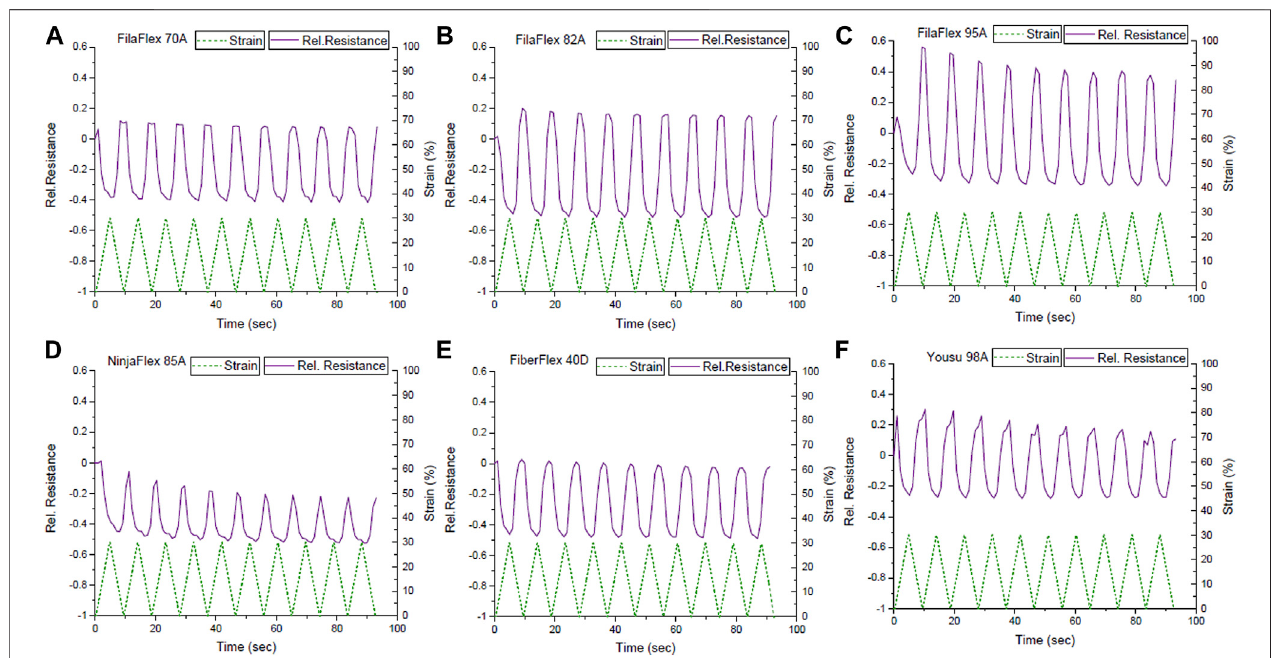
FIGURE 4 | Sensor response during dynamic tensile testing between 0 and 30% strains for the different TPU strips with in situ integrated strain sensing elements; (A) FilaFlex 70A, (B) FilaFlex 82A, (C) FilaFlex 95A, (D) NinjaFlex 85A, (E) FiberFlex 40D, and (F) Yousu 98A.